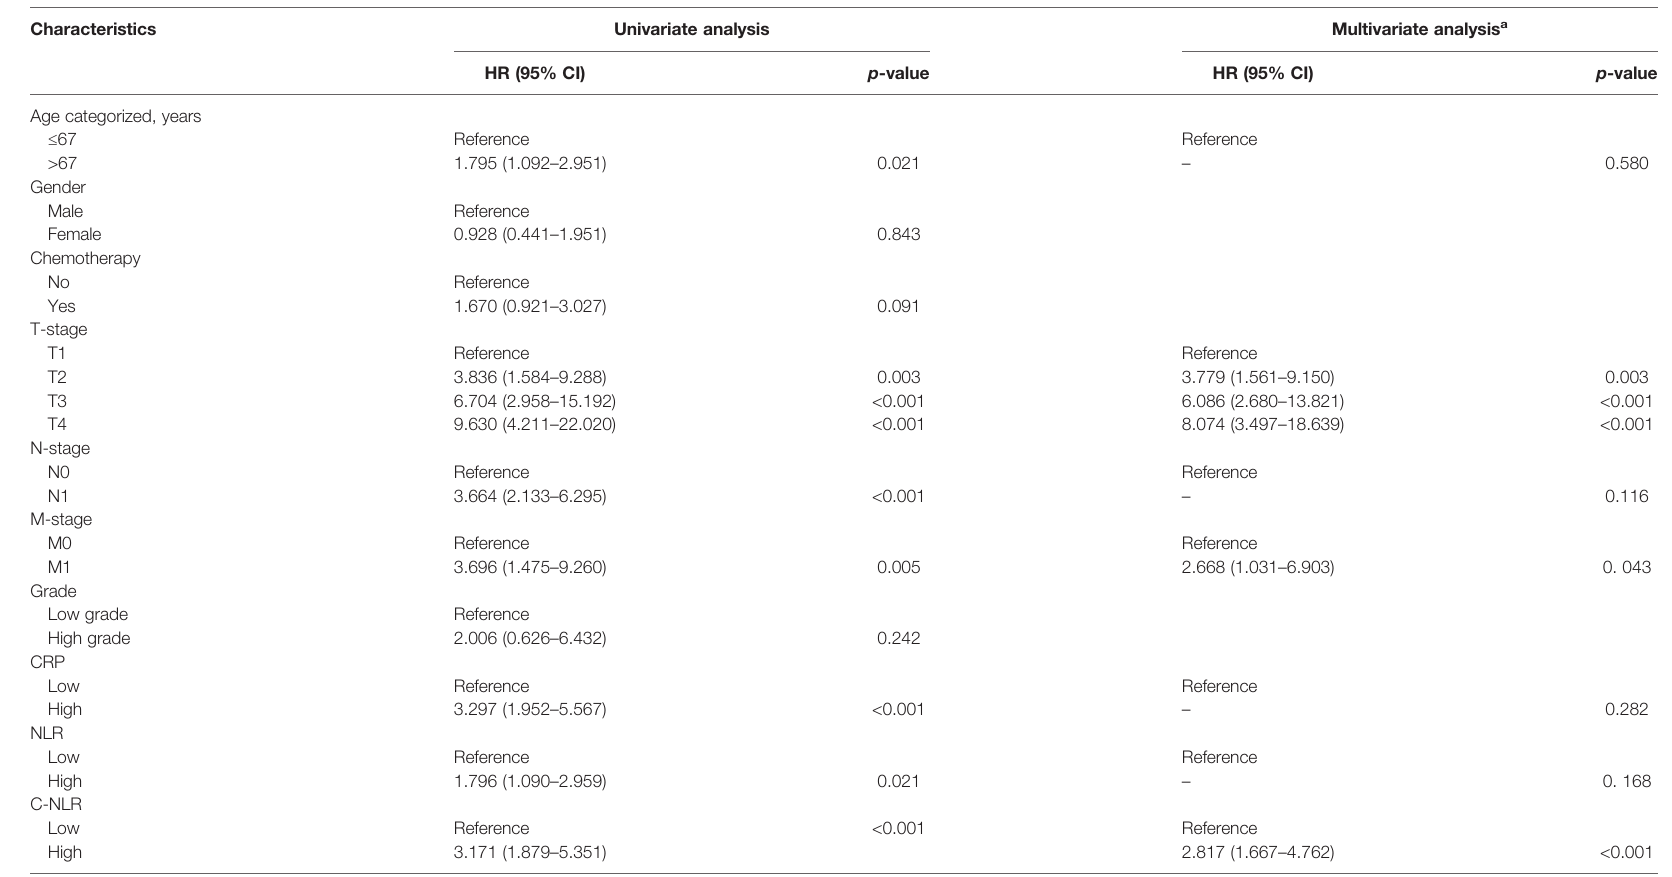
TABLE 6 | Univariate and multivariate analyses of factors associated with disease-free survival